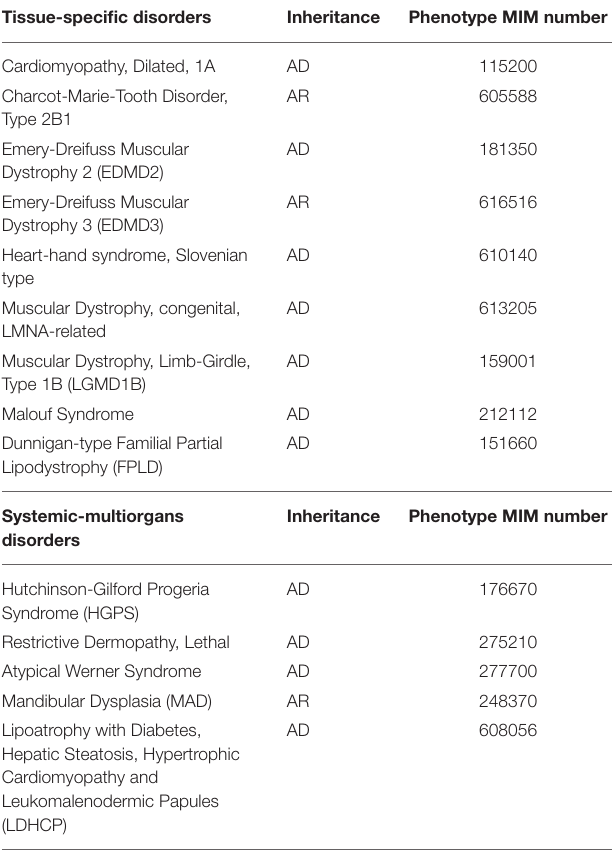
TABLE 1 | Diseases caused by LMNA mutations, classified as tissue-specific or systemic-multiorgans disorders. Tissue-specific